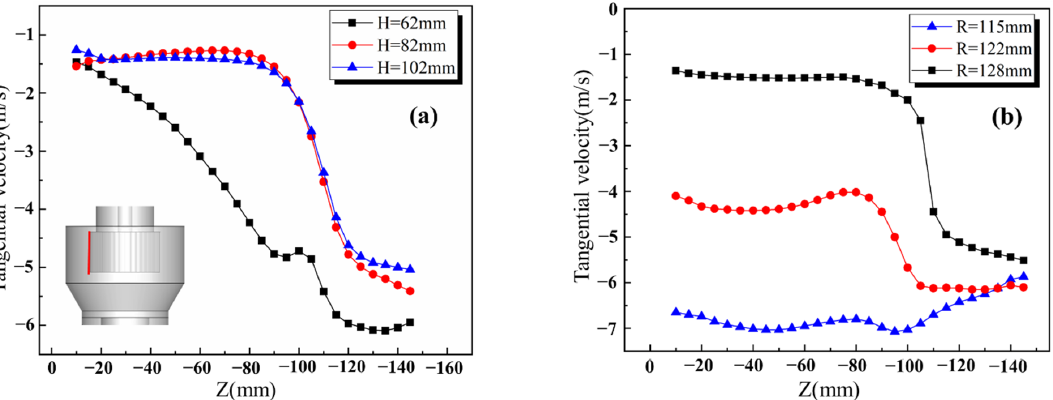
Figure 9. Effects of the guide cone height on the tangential velocity of the rotor cage entrance ( a ) and the tangential velocity for H = 104 mm at different positions in the rotor cage channel ( b ).